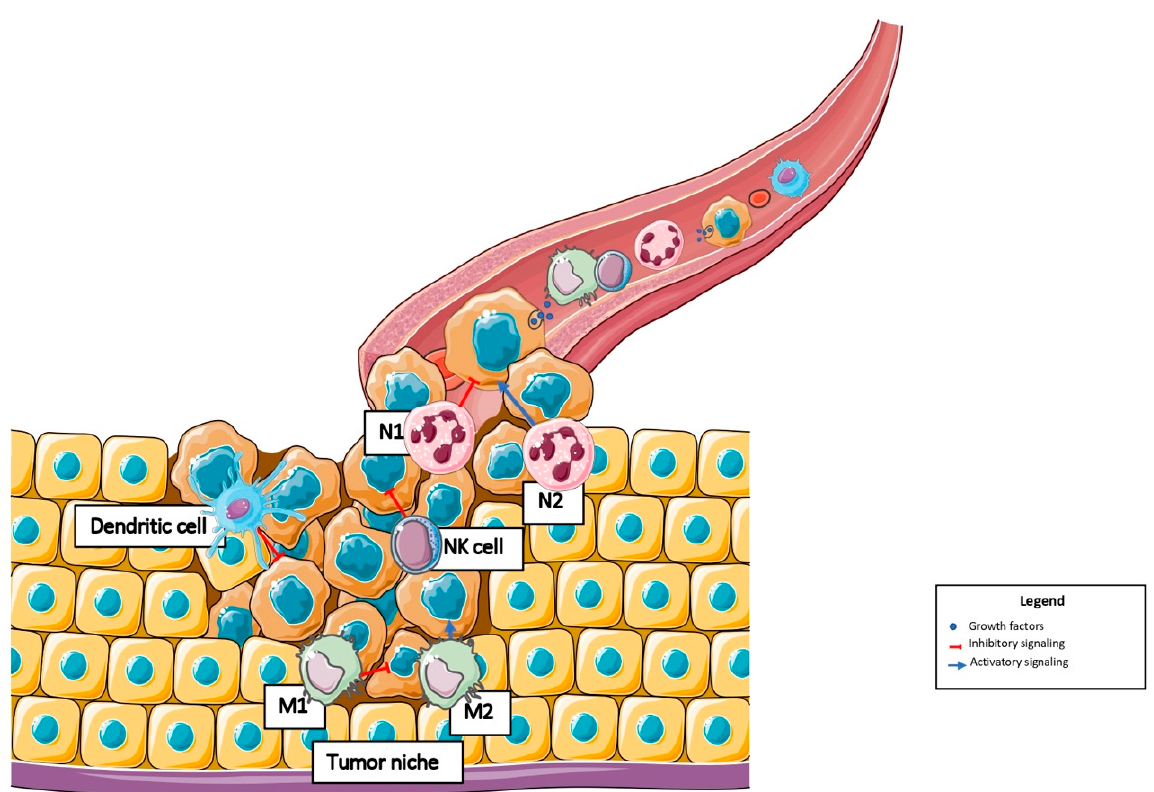
Figure 1. The role of the tumor microenvironment in the composition of the tumor niche in breast cancer. Abbreviations: N1: tumor-associated neutrophil type 1; N2: tumor-associated neutrophil type 2; M1: tumor-associated macrophage type 1; M2: tumor-associated macrophage type 2; NK cell: natural killer cell.